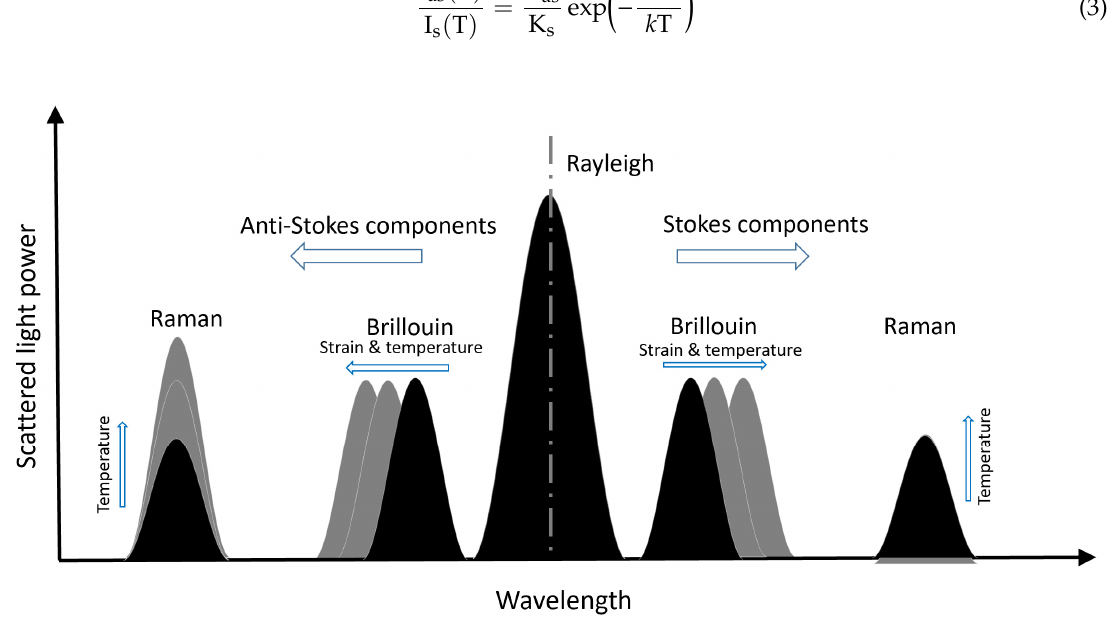
Figure 1. Principles of optical scattering sensors.